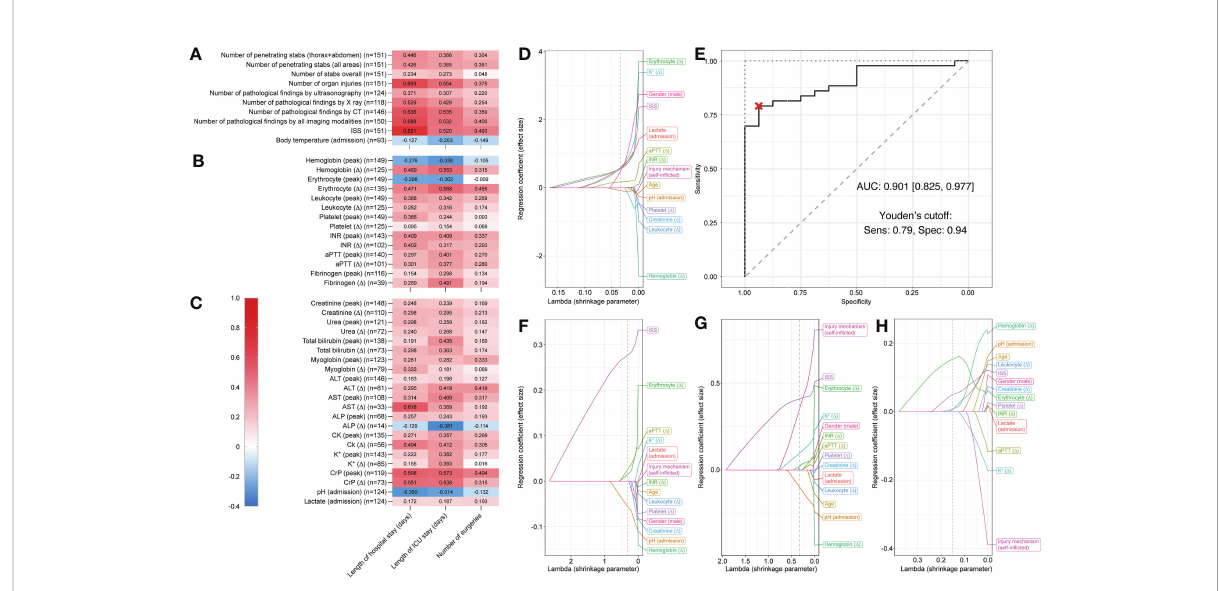
FIGURE 3 Correlation matrix showing Spearman ’ s rank correlation coef fi cients and Least Absolute Shrinkage and Selection Operator (LASSO) plots showing regression coef fi cients for patients who suffered thoracoabdominal stab injuries. Correlation strength is indicated by color scale on the left. Correlations between three different outcome parameters (length of hospital stay, length of ICU stay, and number of surgeries) and (A) injury speci fi cs, (B) routine hematology and coagulation, and (C) serum biochemistry and venous blood gas laboratory parameters for penetrating injuries (n = 151). Multivariable LASSO trace plots indicate potentially predictive sets of variables for (D) ICU admission (yes/no). (E) Receiver operating characteristic (ROC) curve for the LASSO model of ICU admission (yes/no). Youden ’ s cutoff indicates the optimal cutoff based on sensitivity (Sens.) and speci fi city (Spec). (F) Further LASSO trace plots for length of hospital stay, (G) length of ICU stay, and (H) number surgeries. Grey dotted line displays optimal lambda value calculated via cross-validation. AUC, area under the